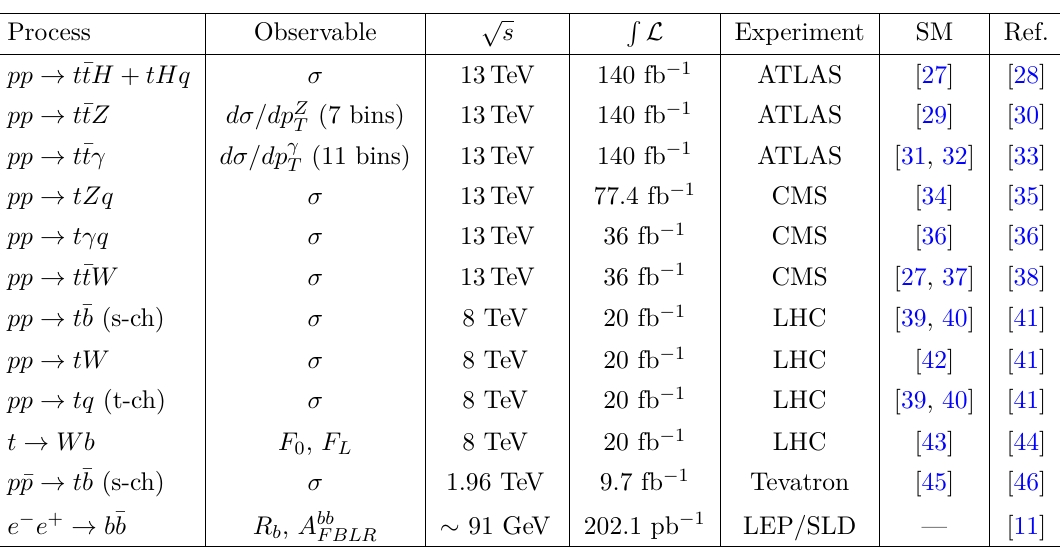
Table 1 . Measurements included in the EFT fit of the top quark electro-weak sector. For each measurement, the process, the observable, the center-of-mass energy, the integrated luminosity and the experiment/collider are given. The last two columns list the references for the predictions and measurements that are included in the fit. LHC refers to the combination of ATLAS and CMS measurements. In a similar way, Tevatron refers to the combination of CDF and D0 results, and LEP/SLD to different experiments from those two